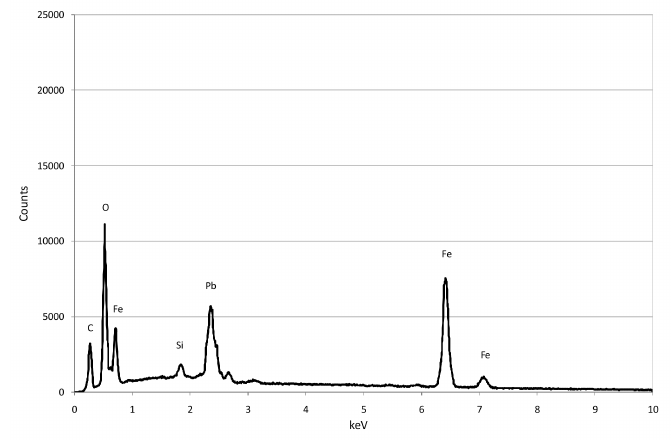
Figure 16. EDS spectrum of commercial mZVI particles after the lead removal treatment.